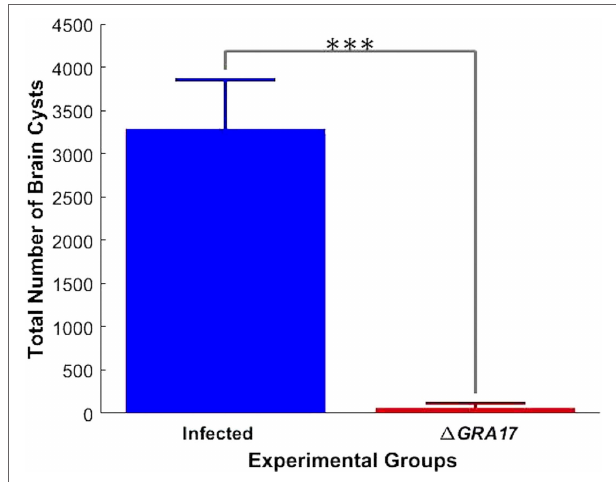
FigUre 11 | Immunization decreases the parasite tissue cyst burden in infected dams. Female mice were immunized with Δ GRA17 and 70 days after they were mated and gavaged orally with 10 Pru cysts on day 12 of gestation. At 30 days after delivery, the cysts loads in brain tissue were analyzed. Non-immunized dams showed higher tissue burdens of cysts than immunized mice. Data points indicate means ± SD. Significance compared with infected mice: *** p < 0.001.